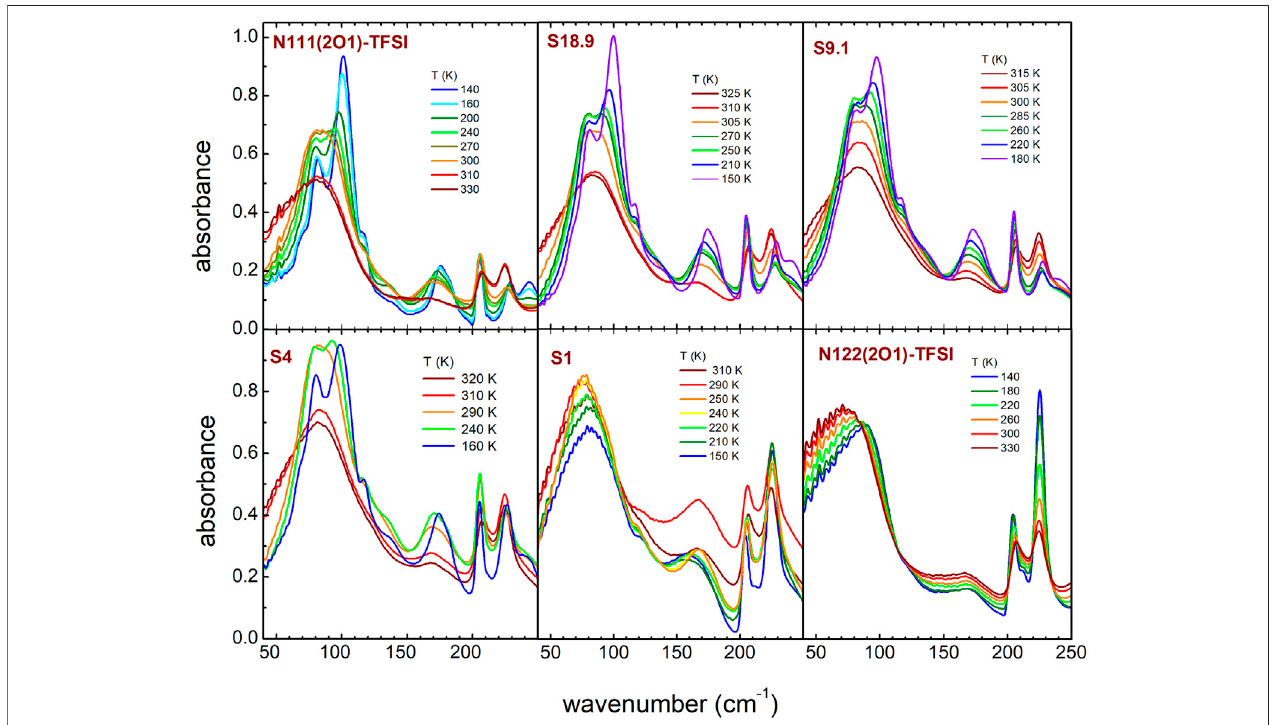
FIGURE 5 | Temperature dependence of the infrared absorption spectra of N111(2O1)-TFSI, N122(2O1)-TFSI and all their mixtures, measured on heating in the wavenumber range between 40 and 250 cm − 1 .